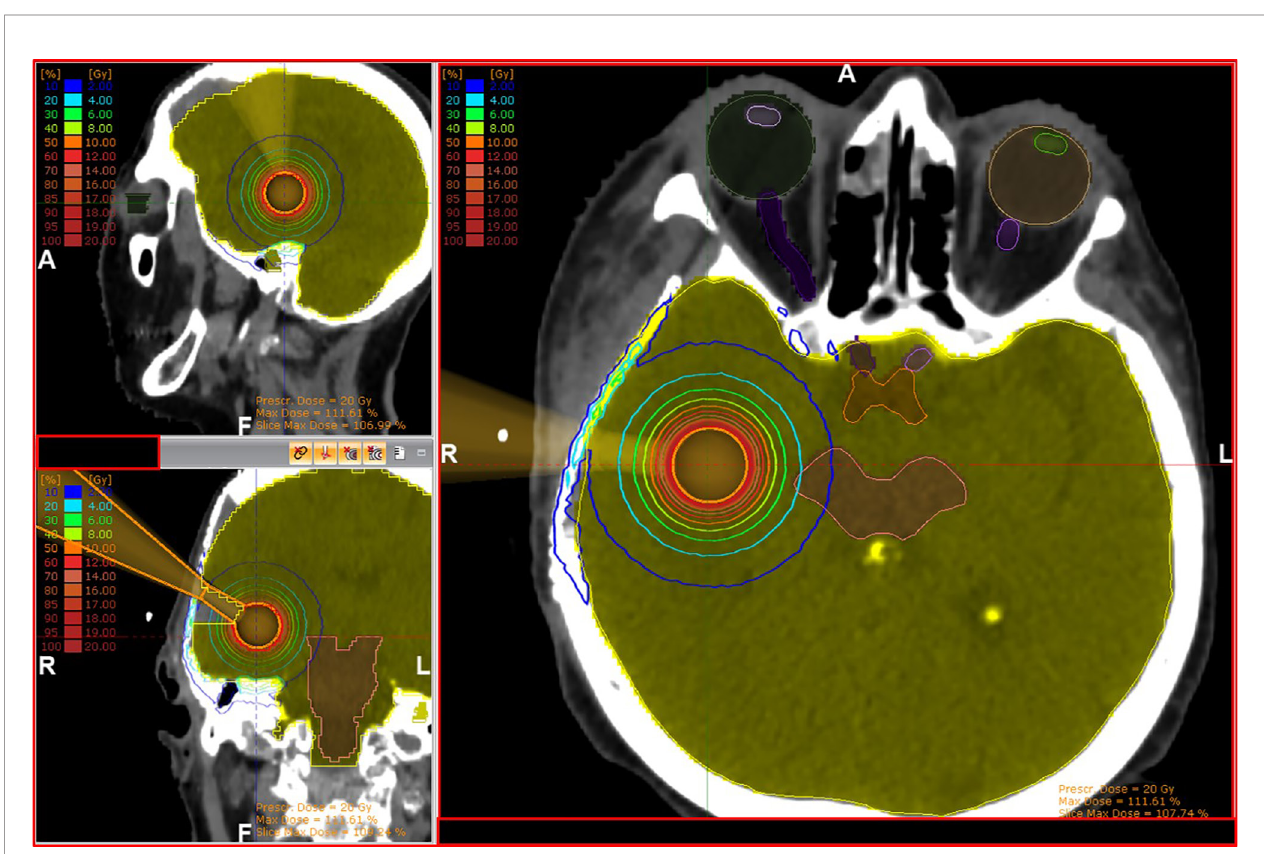
FIGURE 2 | Exemplary case with three-dimensional views of isodose line distribution for a 2.5-cm IORT applicator. Doses reaching the reconstruction plaque should be disregarded to resemble a real-world surgical